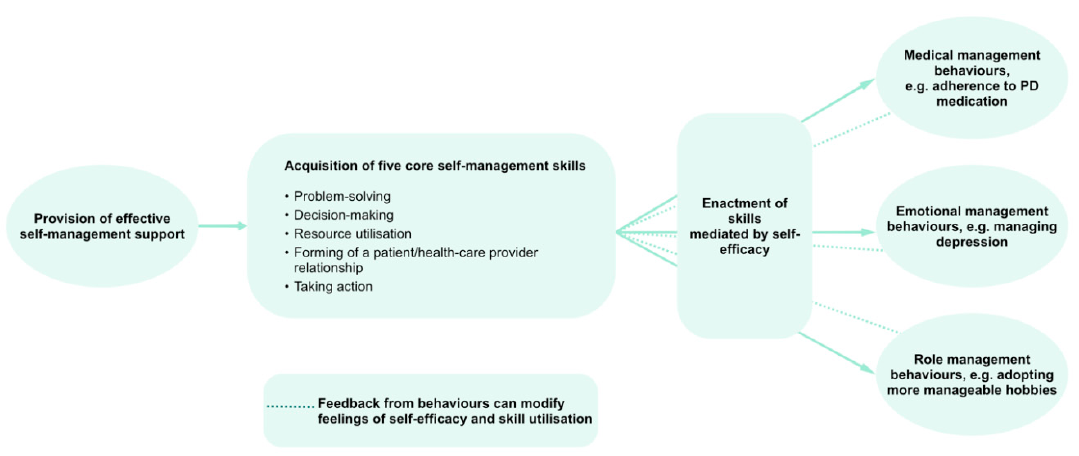
Figure 3. Structural effects model for SME interventions according to the theory of behavioral change. Adopted from [5].